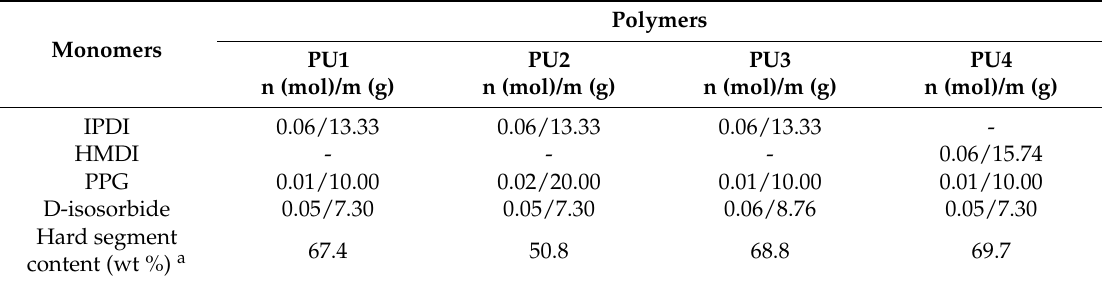
Table 2. The molar and mass ratios of the monomers and prepolymer employed in the synthesis of the polyurethanes PU1–PU4 , and the hard segment content (wt